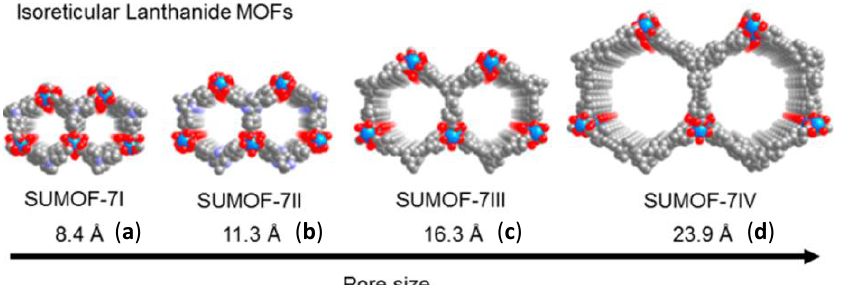
Figure 2. Crystal structures of SUMOF-7I ( a ), SUMOF-7II ( b ), SUMOF-7III ( c ), and SUMOF-7IV ( d ). The diameters of the corresponding pore apertures are 8.4, 11.3, 16.3, and 23.9 Å, respectively (taking into account the van der Waals radii of the atoms) [60]. Reproduced from ref. [60] with permission from the American Chemical Society, copyright